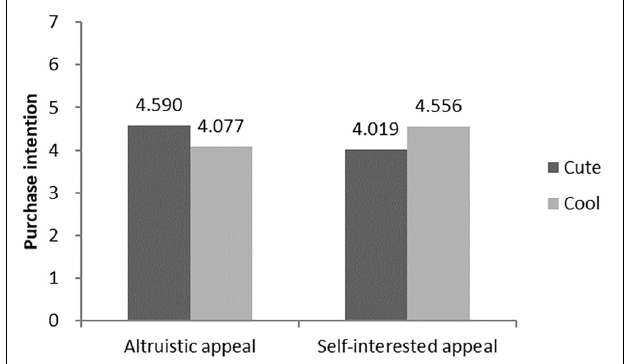
FIGURE 4 | Brand anthropomorphic images of cuteness (A) and coolness (B) in Study